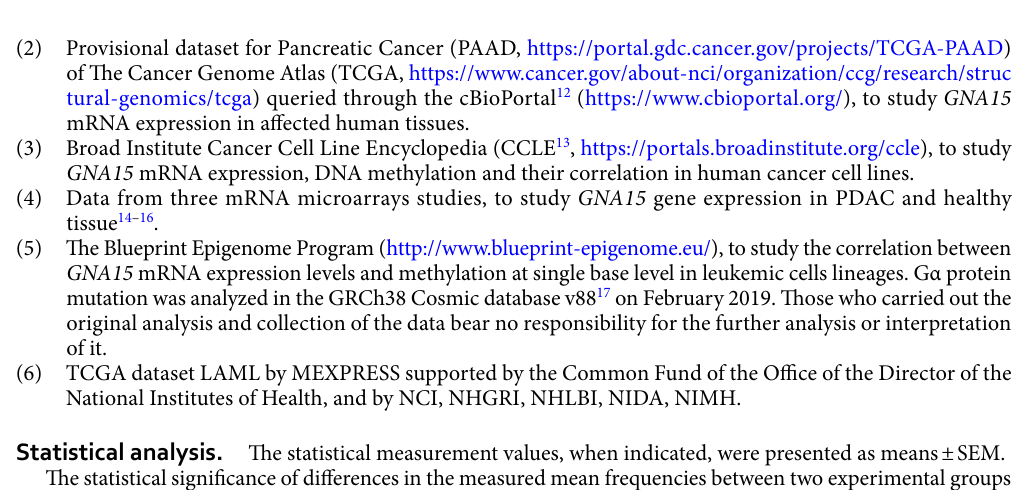
Figure 1. GNA15 differential expression in normal tissue and cancer. Median gene expression across several tumor samples and paired normal tissues utilizing